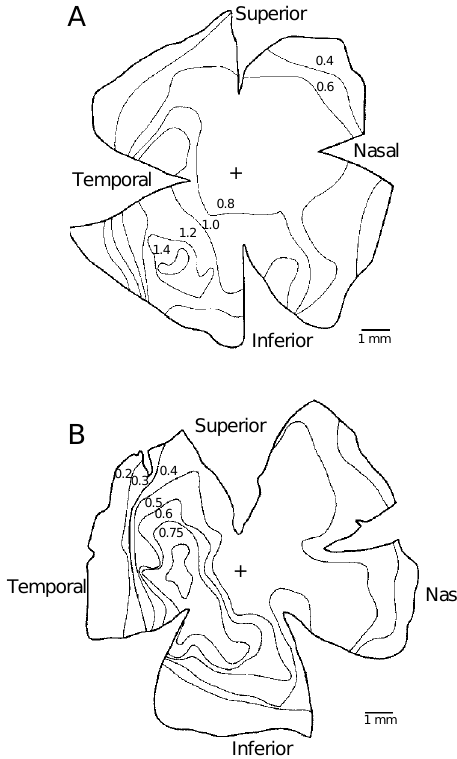
Figure 3 - Distribution of gan- glion cell densities in the right retina of a three-toed sloth Bradypus variegatus (A) and of a two-toed sloth Choloepus didac- tylus (B). Numbers next to each isodensity line represent cells/ mm 2 divided by 1000. The cross marks the position of the optic disc. Note the different position of the region of maximum cell density (area centralis) between the sloth species. In both in- stances the presence of a visual streak in the retina is indicated by the elongated contours of the isodensity lines representing in- termediate densities around the area centralis, this being 0.8 x 10 3 in Bradypus variegatus and 0.4 x 10 3 in Choloepus didacty- lus